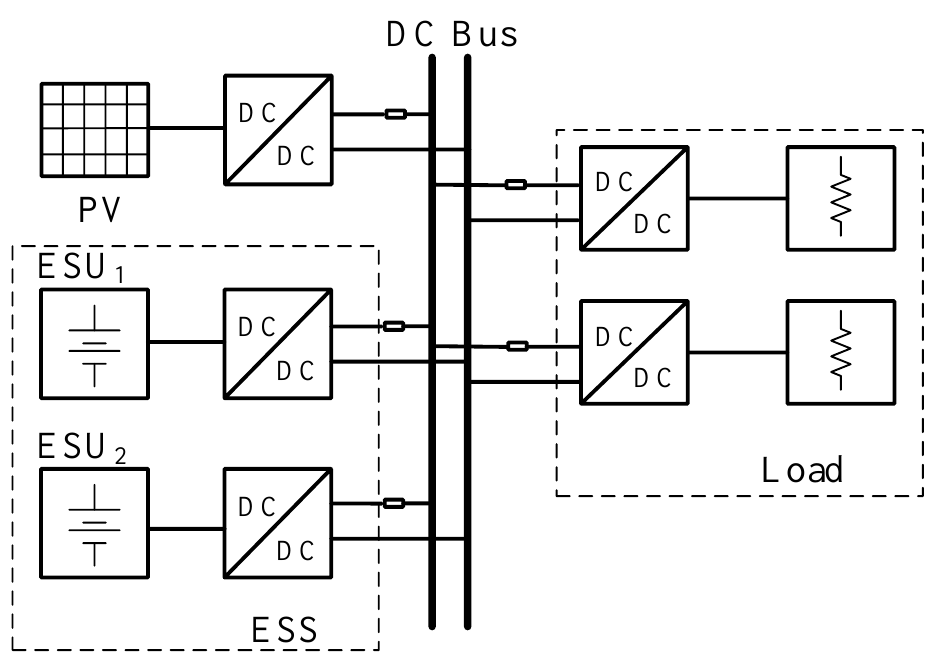
Figure 1. Topology of islanded DC microgrid.